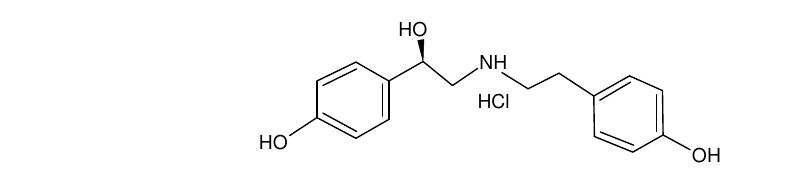
Figure 1 . Chemical structure of ritodrine